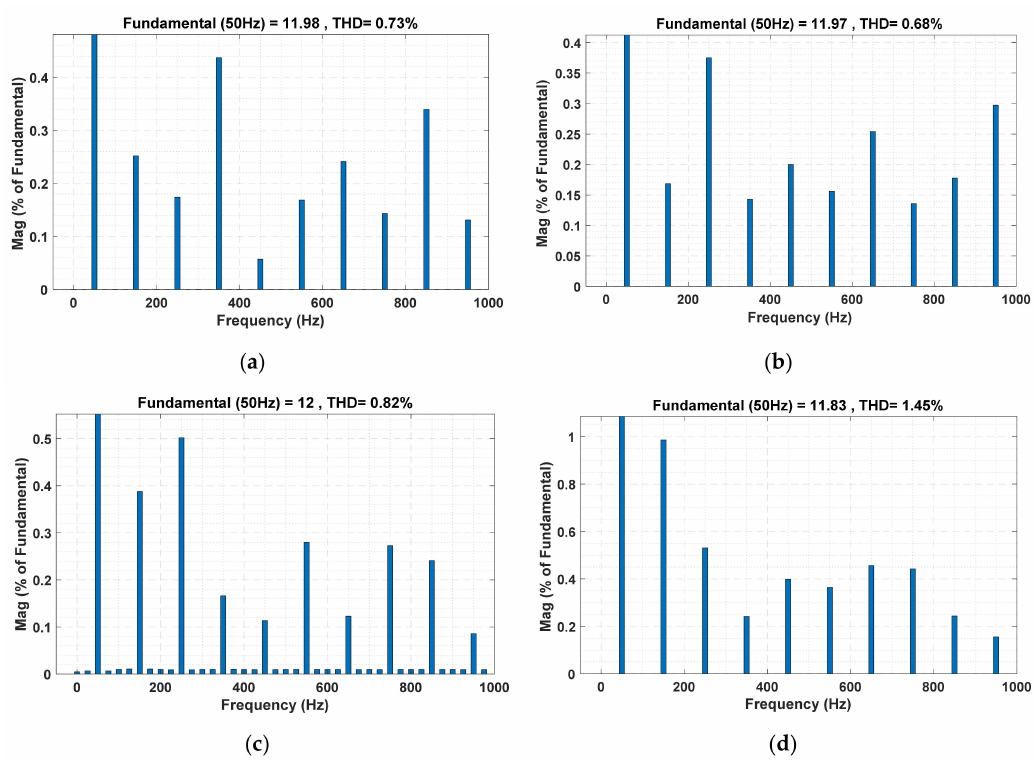
Figure 22. Harmonic spectra for ( a ) PSO-OFHCC, ( b ) FBI-OFHCC, ( c ) AOA-OFHCC, and ( d ) IAOA-